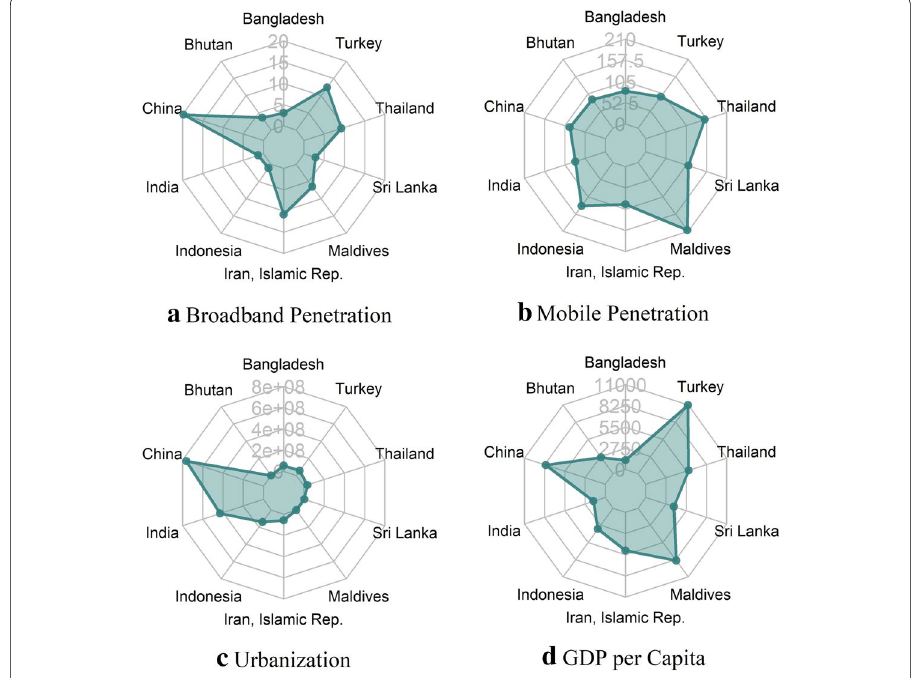
Fig. 3 Radar chart of variables by countries in 2015